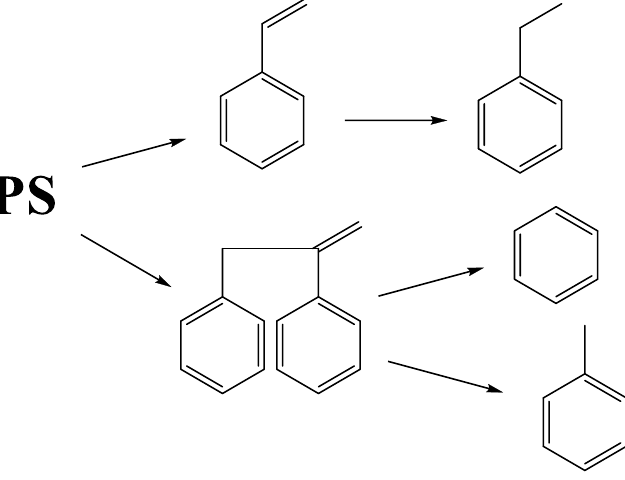
Figure 11. Scheme of the PS decomposition ways.